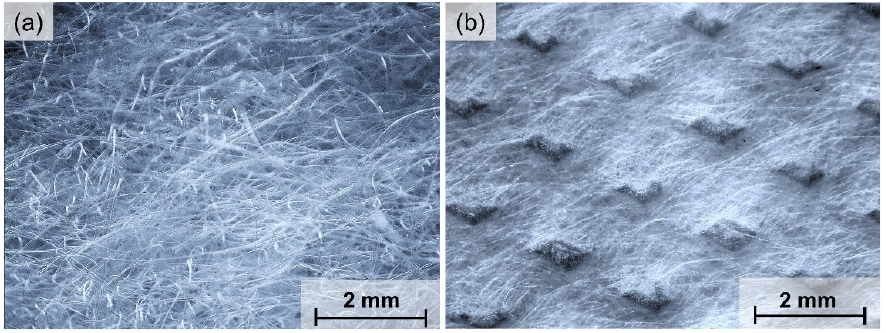
Figure 1. Optical microscopy images surface of tested nonwovens based on PLA: ( a ) melt ‐ blown; ( b ) spun ‐ bonded.